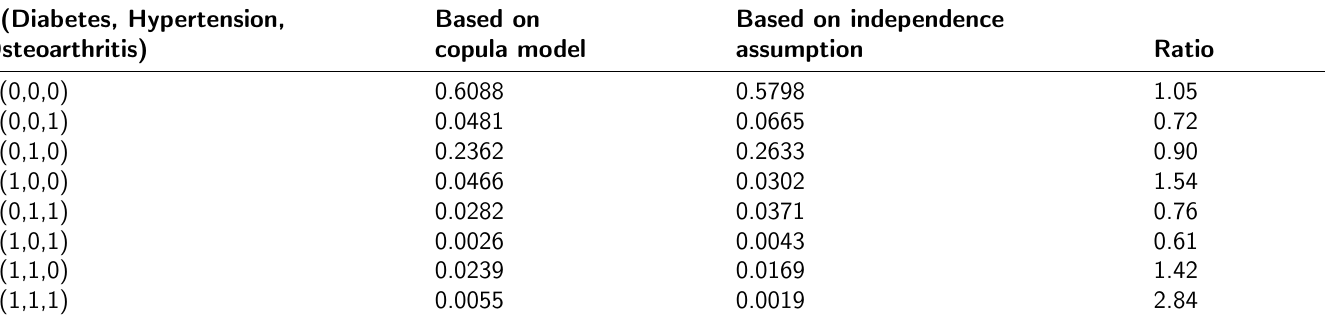
Table 5: Trivariate probabilities for simulated